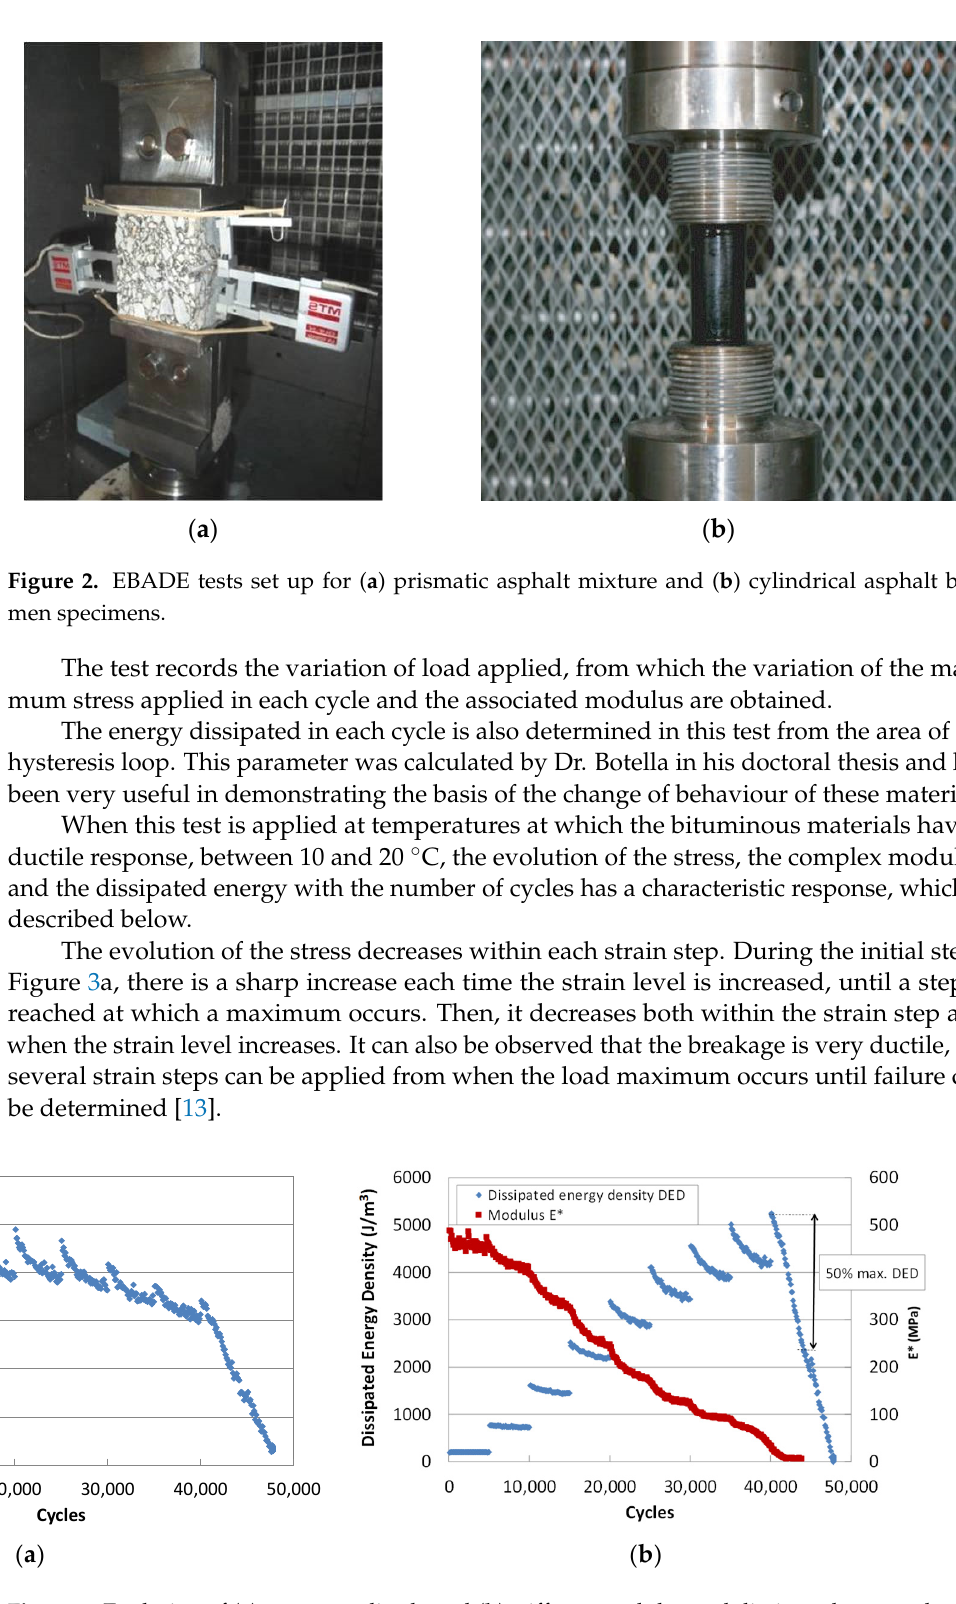
Figure 3. Evolution of ( a ) stress amplitude and ( b ) stiffness modulus and dissipated energy density with loading